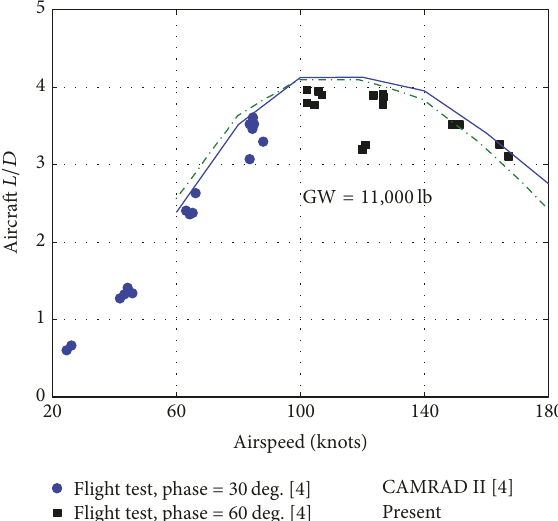
Figure 11: Validation of aircraft lift-to-drag ratio in pure helicopter mode.